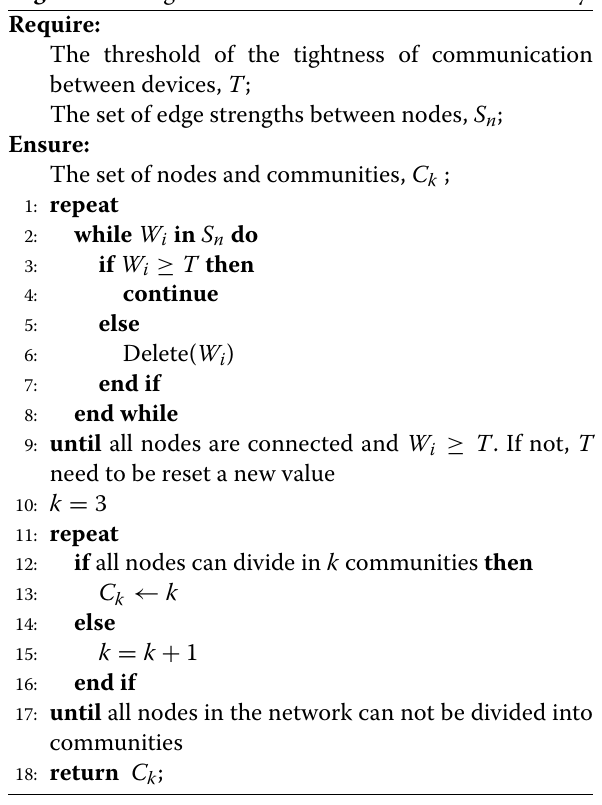
Algorithm 1 algorithm of nodes divided into